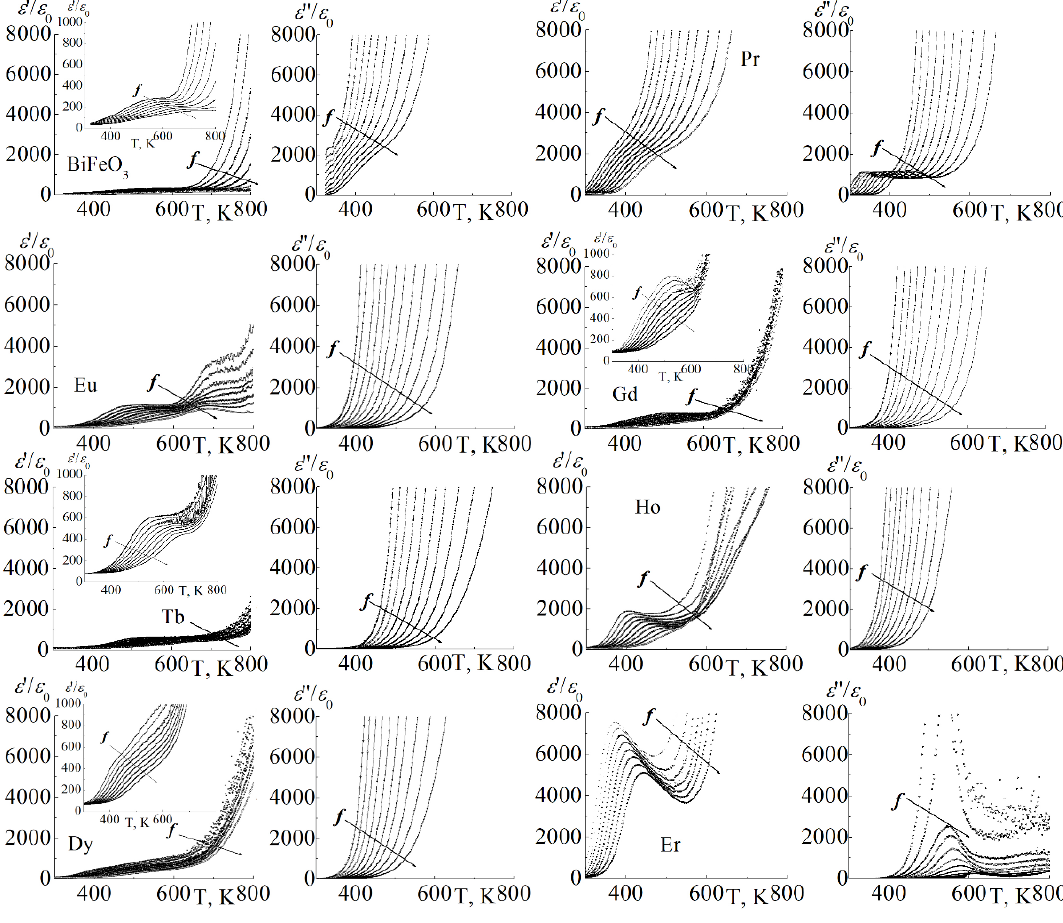
Figure 1. Temperature dependences of ε′ / ε 0 , ε″ / ε 0 BiFeO 3 and BiFeO 3 /REEx ( x = 0.1) in the frequency range of (25 ÷ 2·10 6 ) Hz of the ac field.